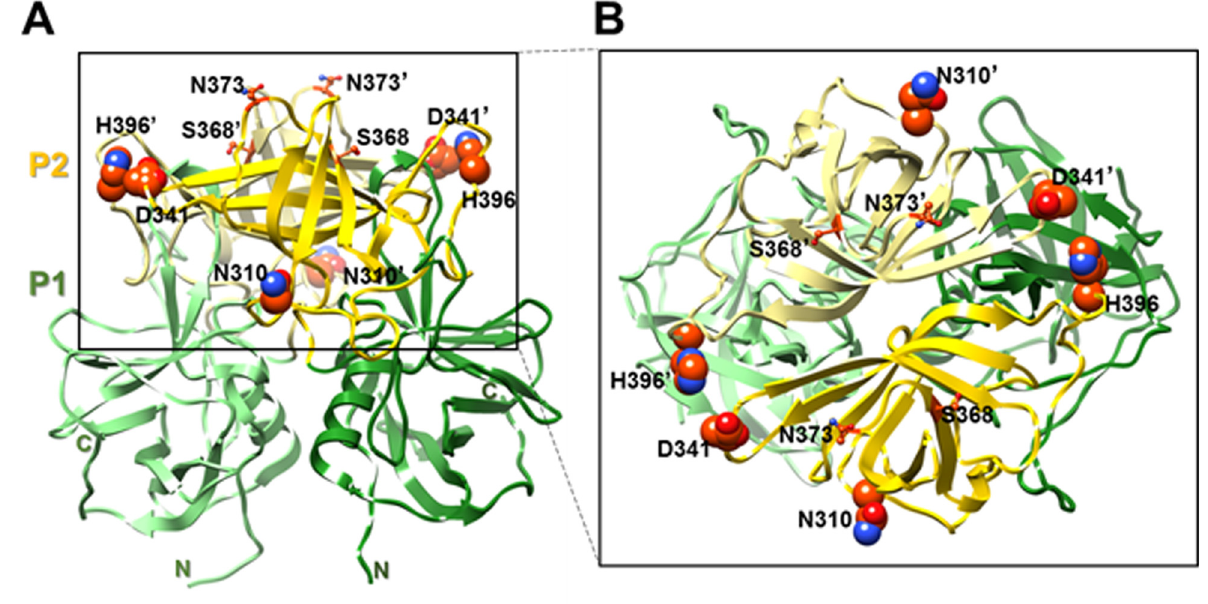
Fig 4. Mapping of amino acid (aa) sequence variations between strains on the P domain of capsid protein VP1. (A) Cartoon representation of the P domain of capsid protein VP1 dimer (side view) (PDB ID: 3SLD). The P1 (aa 225 – 278 and 406 – 519) and P2 (aa 279 – 405) subdomains are colored in green and yellow, respectively. Side chains of key aa are shown, with N310, H396 and D341 presented as spheres. The residues in the opposing subunit of the dimer are labeled 0 . (B) Top view of the P-domain dimer. The two subunits are shown in yellow and light yellow, respectively. Amino acids are labeled as in